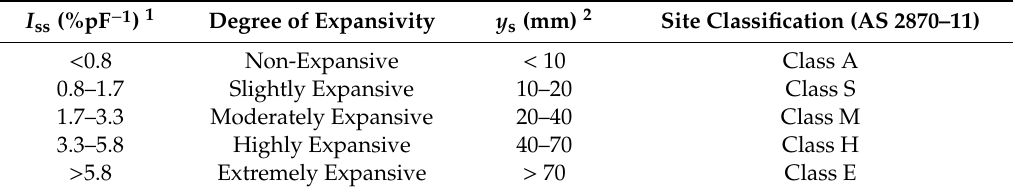
Table A2. Classification procedures for expansive soils based on the shrink–swell index I ss